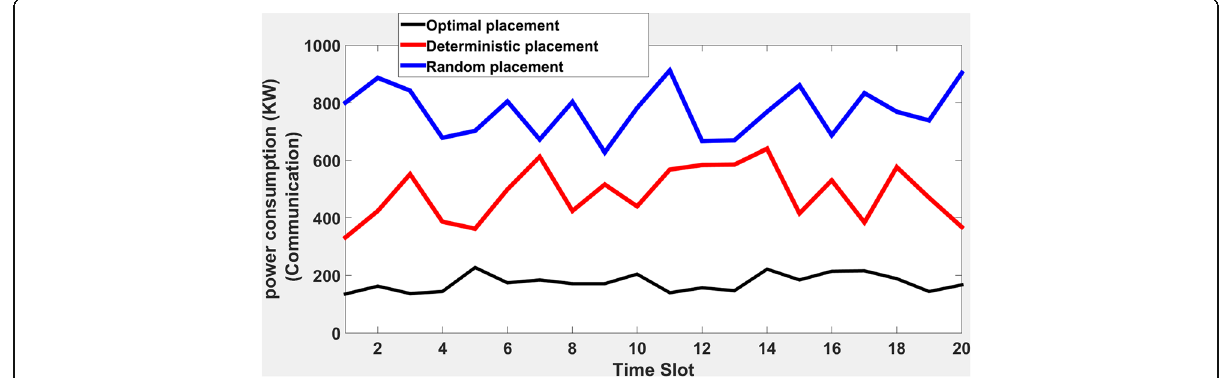
Fig. 8 Communication power consumption for the optimal placement with migration (Gr =0.3) together with deterministic and random heuristics as a function of time